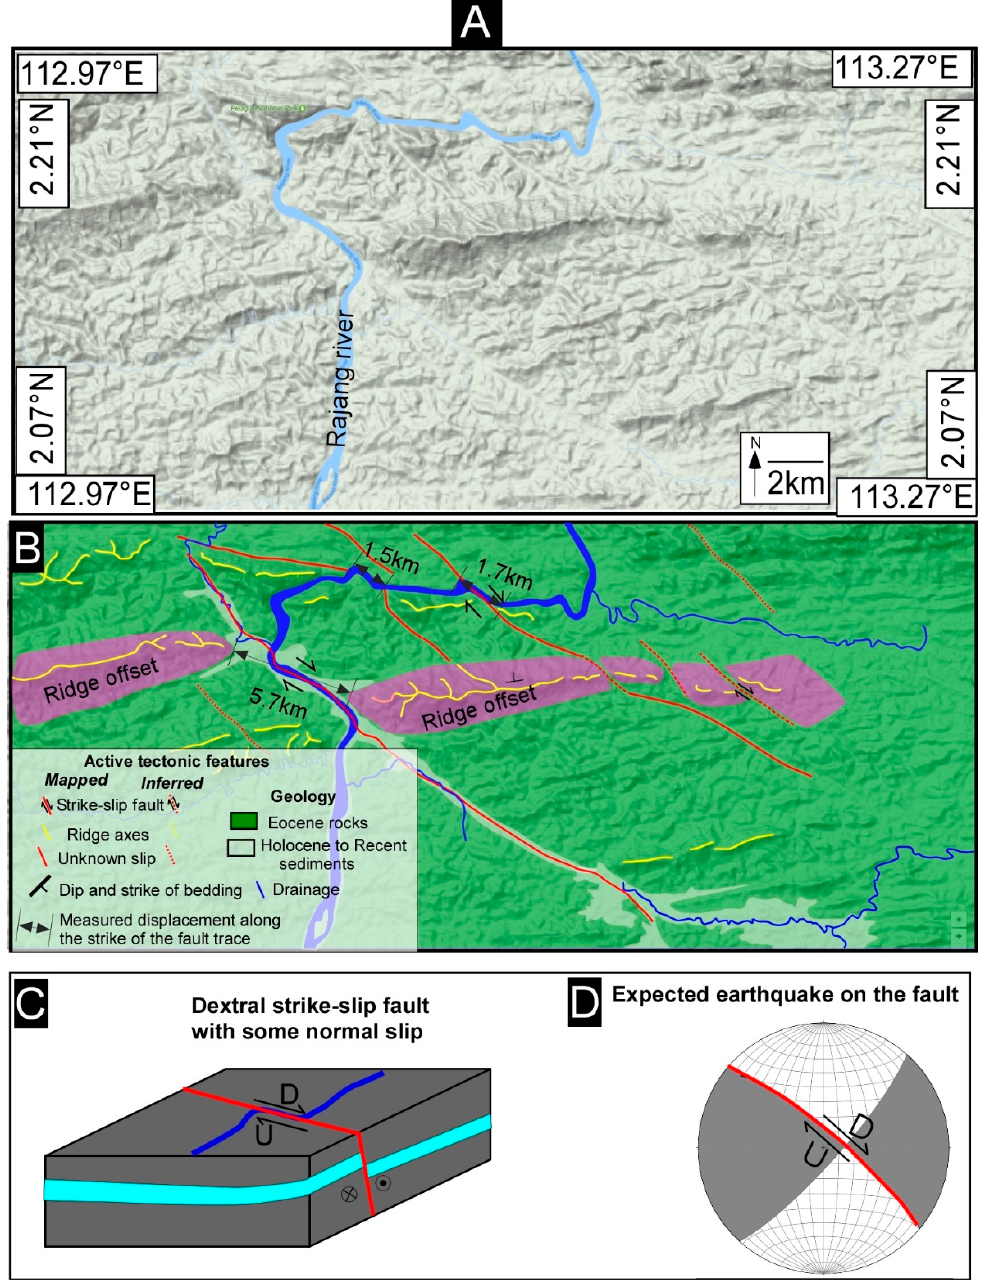
Figure 4. ( A ) Un-interpreted Google terrain image. ( B ) Evidence of dextral strike-slip faulting. ( C ) Cartoon shows the possible dip and dip direction of faulting. ( D ) The expected fault plane solution. The large river seems to have a sinistral offset but it is actually following the extent of dextral offset of the fault that cuts through the ridge for ~5.7 km.